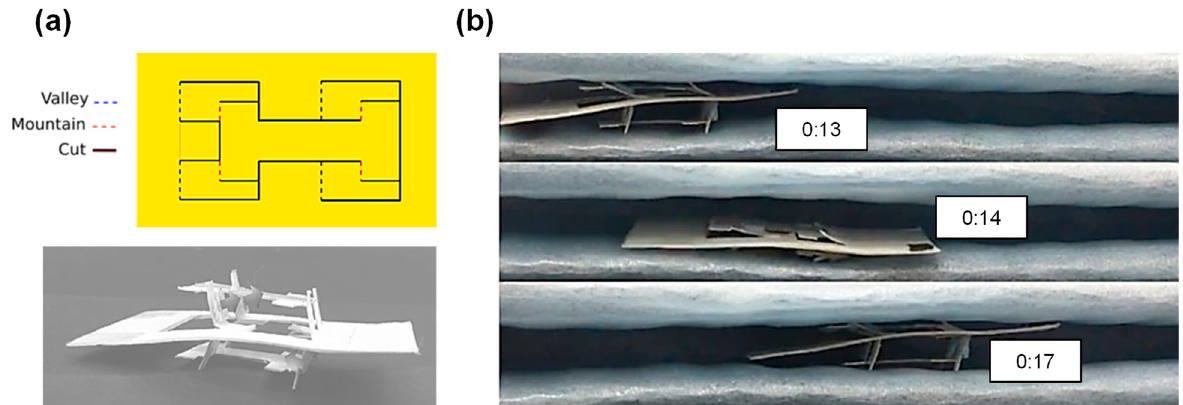
Figure 3. DDLEM prototype. ( a ) Design of LEM with dual-layer (DLLEM) structure base. (Top) Crease pattern of the SLEM used, where dotted lines represent the mountain and valley folds, cuts are represented by continuous black lines. This LEM design has longer legs (14 mm) than the previ- ous 10 mm SLEM. (Bottom) Prototype of DLLEM with dual pop-up surfaces. ( b ) Movement of DLLEM structure in a confined environment.